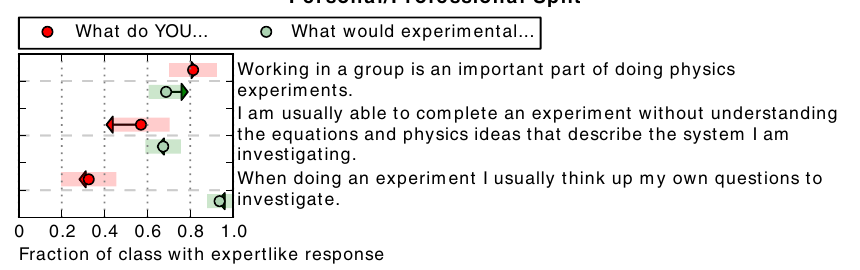
FIG. 7. Comparison of changes in students ’ personal views versus their views about professional physicists. Red shows the change in students ’ response to “ What do YOU think when doing experiments for class? ” . Green shows the change in students ’ responses to “ What would experimental physicists say about their research? ” . The circles show the presemester survey values. The arrows indicate the pre and post shift. The shaded bars are 95% confidence intervals. The data shown are for a subset of 3 out of 30 statements.